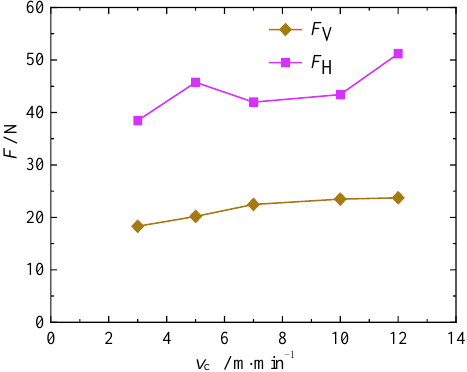
Figure 4. Cutting force at different cutting speeds.